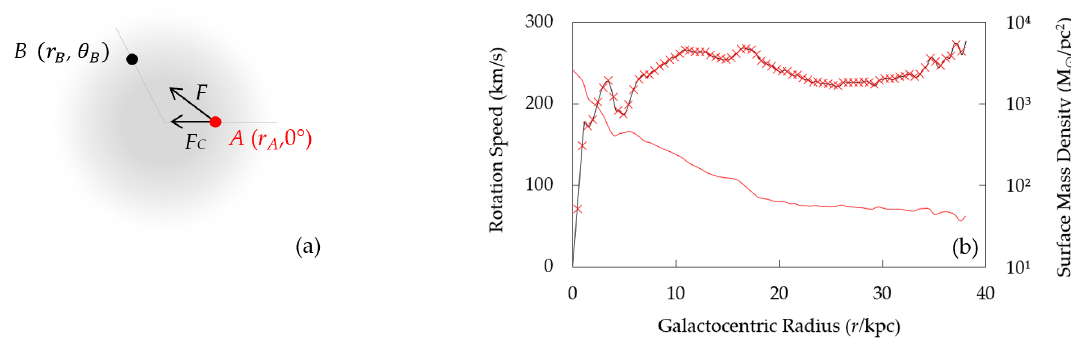
Figure 1. ( a ) Illustration of the centripetal component of the gravitational force vector. The gravitational → F acting on mass at point A due to mass at point B is shown as the longer arrow . Its centripetal force → F C is shown as the shorter arrow . ( b ) Illustration of Disk Mass Density Model (DM2) tracking the component input rotation curve. The black solid curve is M31 galaxy rotation curve from Chemin et al., 2009 [31]. The red solid curve represents the surface mass density profile generated by DM2 based on the input rotation curve. Red crosses represent the reverse conversion of the computed density profile back into a rotation